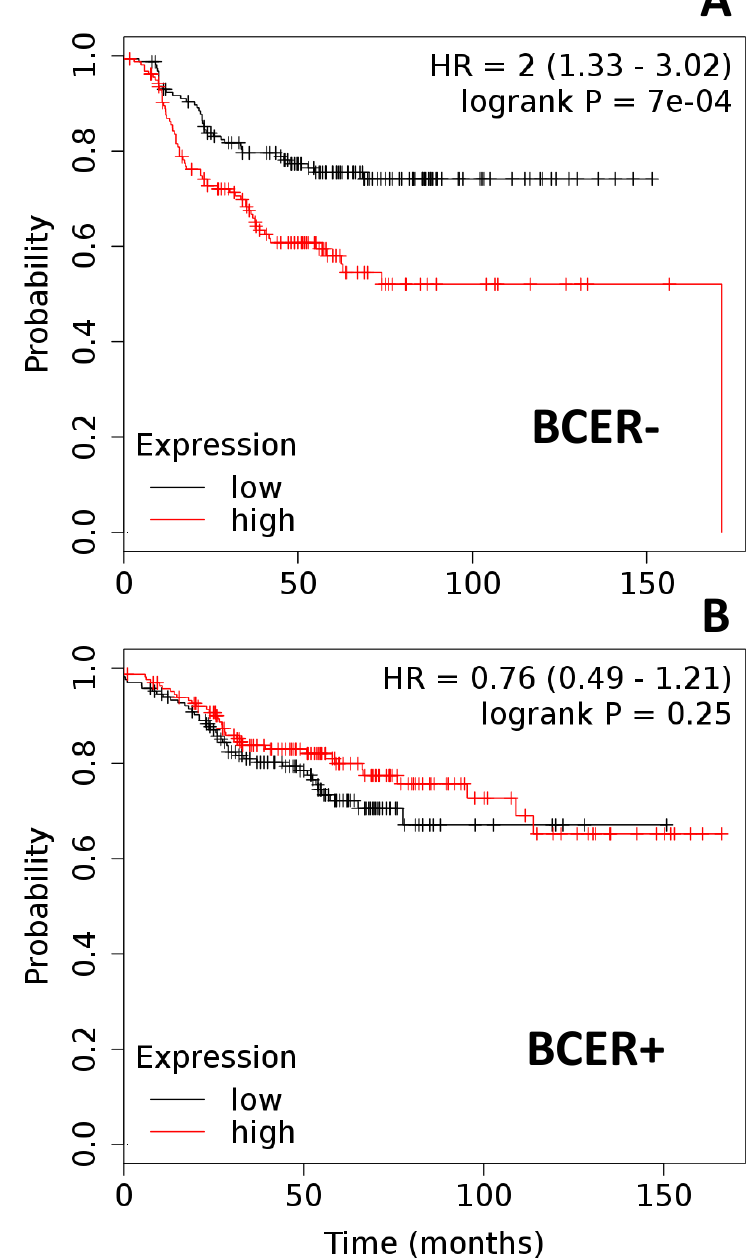
Figure 4. Co-expression of OBR and targeted genes and survival of ER-negative (BCER − ) and -positive (BCER + ) breast cancer patients treated with chemotherapeutics. ( A ) Survival curves of BCER − patients ( n = 315) with low and high co-expression of CDK8–NANOG–RBPJk–OBR. ( B ) Survival curves of BCER + patients ( n = 331) with low and high co-expression of CDK8–NANOG–RBPJk–OBR. Kaplan–Meier survival plots were calculated using data from the Cancer Genome Atlas (TCGA) [18–21]. Graphs depict relapse-free survival. Patients surviving beyond the timeline threshold (20 years and 10 months) were censored instead of excluded. Hazard ratio (HR) range and p- values (logrank P) were obtained for the BC patients using Kmplot.com software [46].